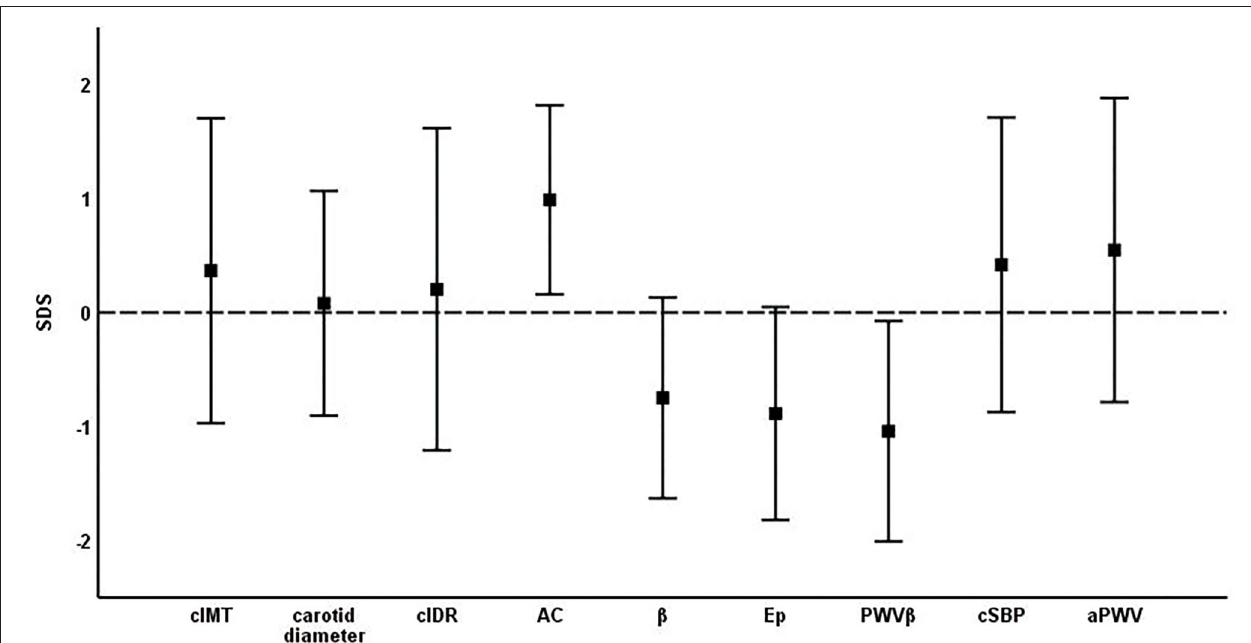
FIGURE 2 | Mean ± standard deviation of SDS of vascular parameters. cIMT, carotid intima-media thickness; cIDR, carotid intima-media thickness ÷ carotid diameter ratio; AC, arterial compliance; β , beta stiffness index; Ep, elastic modulus; PWV β , carotid pulse wave velocity; cSBP, central systolic blood pressure; aPWV, aortic pulse wave